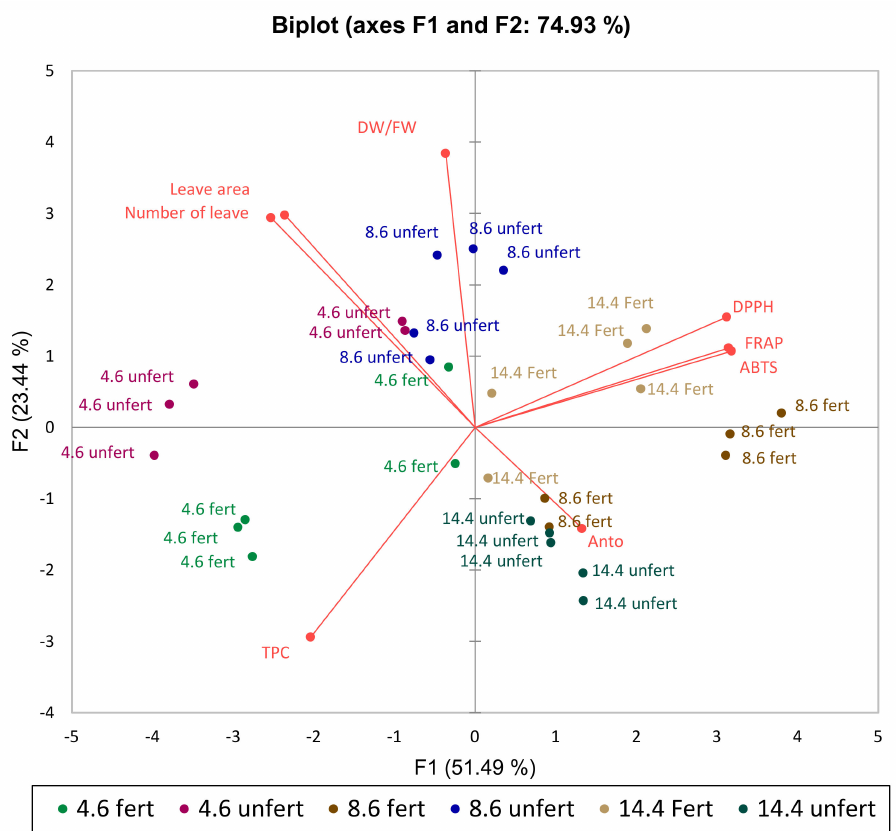
Figure 6. The principal component analysis (PCA) scatterplot indicates distinct differences in phe- nols; FRAP, DPPH, and ABTS radical scavenging activity; DW/FW; anthocyanins; and biometric parameters in lettuce ‘Nikolaj’. Natural light corresponds to 4.6 mol m − 2 d − 1 ; 150 µ mol m − 2 s − 1 corresponds to 8.6 mol m − 2 d − 1 ; 250 µ mol m − 2 s − 1 corresponds to 14.4 mol m − 2 d − 1